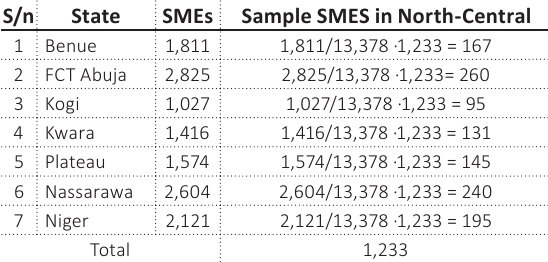
Table 2. Sample size distribution of SMEs in North-Central, Nigeria